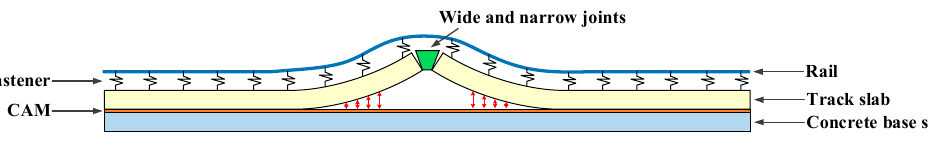
slabTrack slab Concrete base